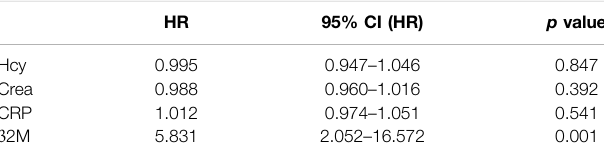
TABLE 6 | Predictive risk factors for recurrent AIS using Cox proportional hazard regression after propensity score matching. HR 95% CI